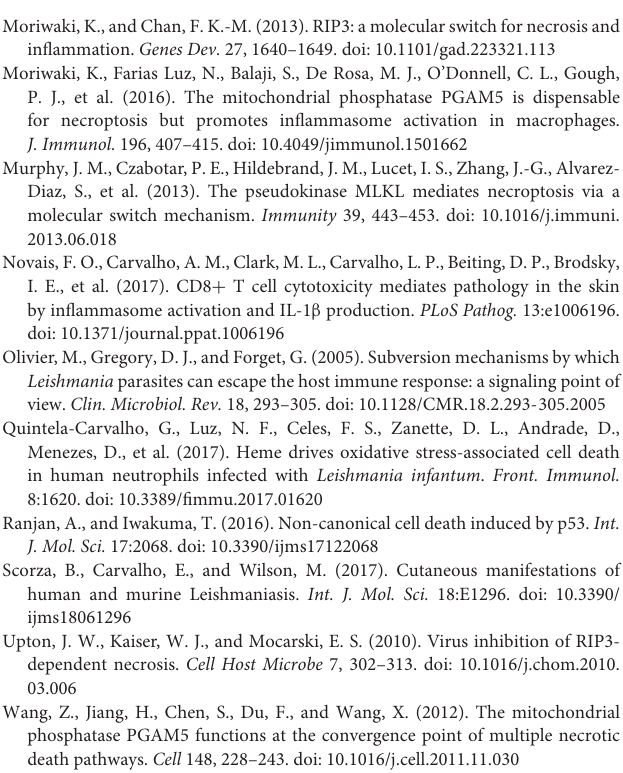
FIGURE S3 | Functional effect of RIPK1, RIPK3 and MLKL inhibitors. THP-1 cells were treated with 10 µ M zVAD-fmk, 5 µ M 7-Cl-O-Nec-1 (RIPK1 inhibitor); 10 µ M assay as described in the Section “Patients and Methods.” Kruskal–Wallis test followed by Dunn’s multiple comparisons test were used to evaluate statistical significance. Three independent experiments were performed. Results shown are mean of quintuplicate ± SEM. ∗ P < 0.001. TABLE S1 | Infiltration score values from LCL skin